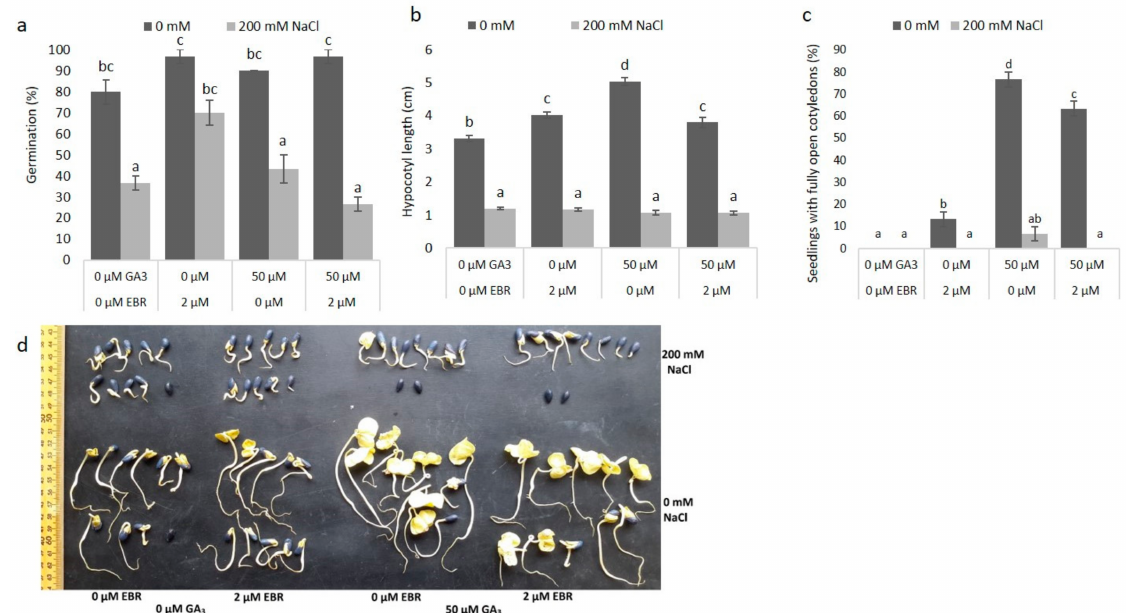
Figure 6. Cotton seed germination and seedling growth under salt stress following treatment with either EBR or GA 3 alone or together. Percent germination ( a ); hypocotyl length ( b ); percentage of seedlings with fully open cotyledons ( c ); and seedling phenotypes ( d ), in response to pre-treatment with EBR (0 and 2 µ M), GA 3 (0 and 50 µ M) and EBR plus GA 3 (as indicated in figures) under 0 and 200 mM NaCl were noted on the 4th and 13th day, respectively. Error bars represents standard error (SE) of the mean for three replicates ( n = 30). Different letters above the bars indicate significant differences in two-way ANOVA ( p < 0.05) followed by Tukey’s post hoc